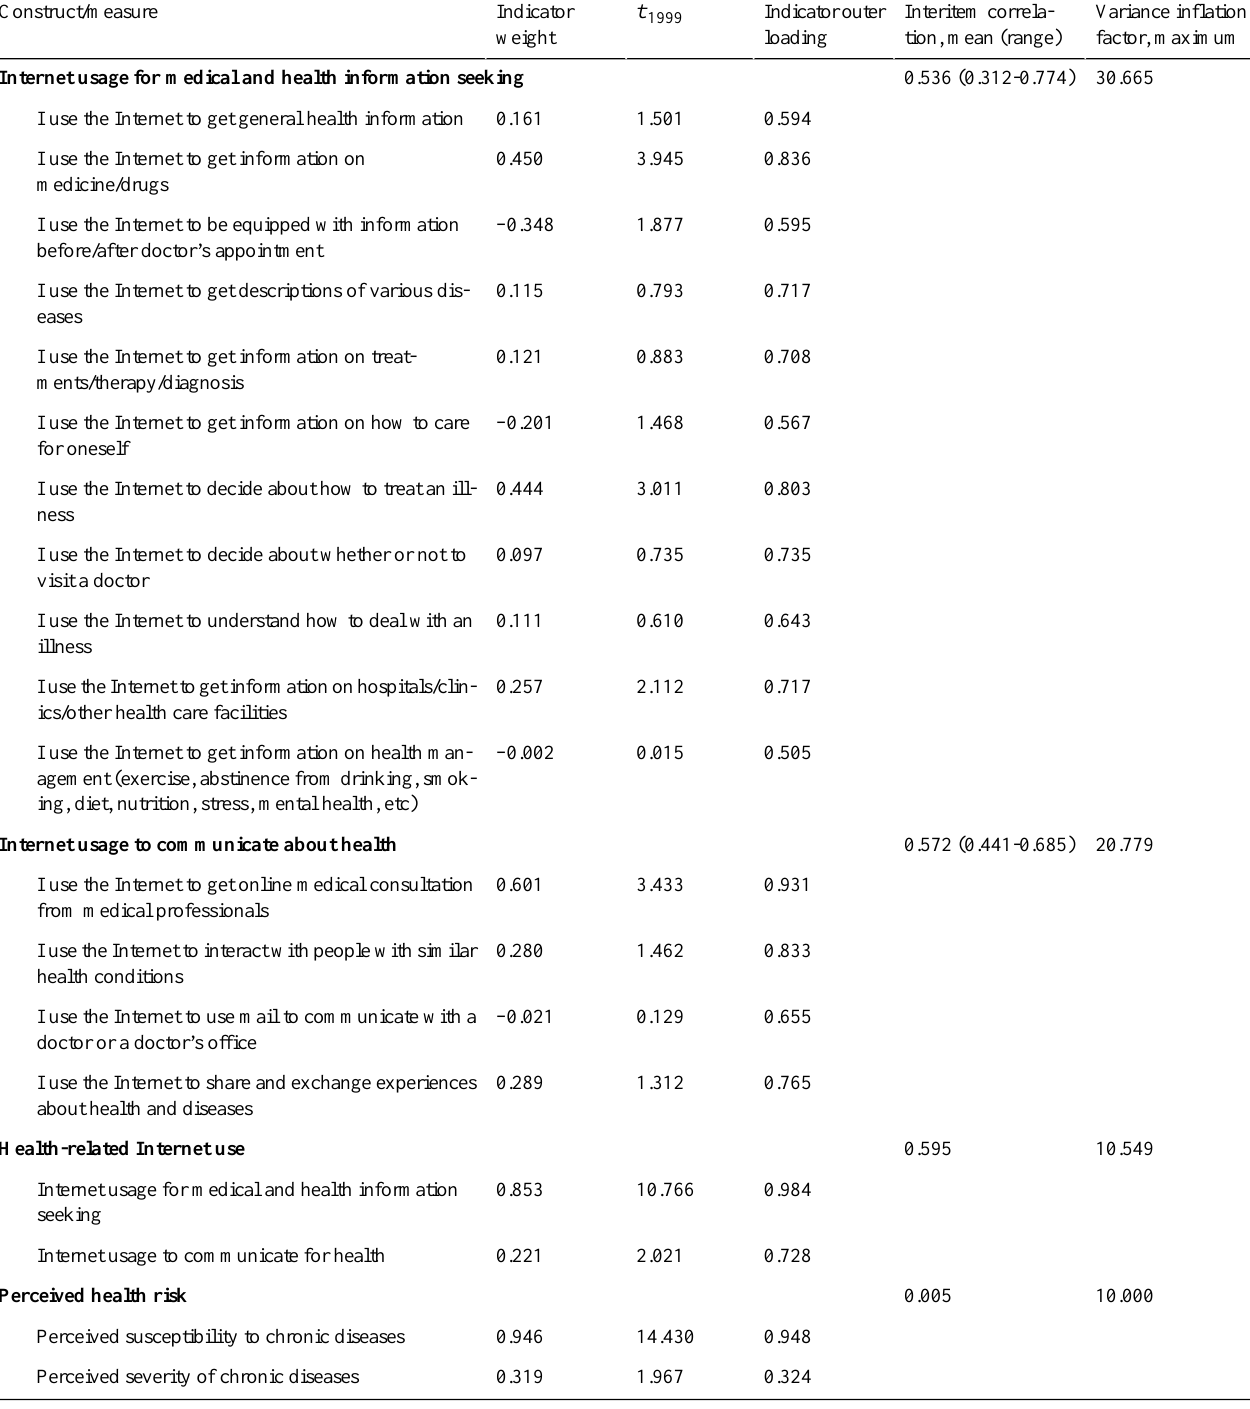
Table 4. Formative constructs assessment.